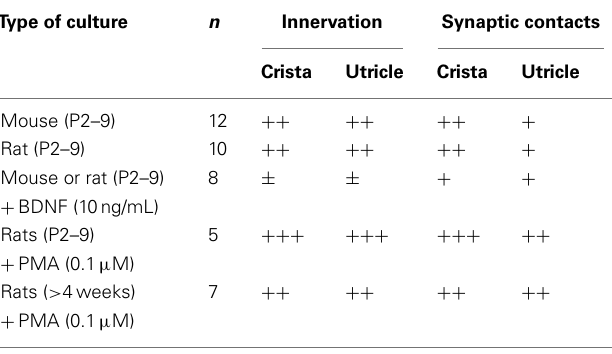
Table 1 | Regeneration of vestibular neurons in different culture conditions. Semi-quantitative comparison of innervation and synaptic contact re-connections evaluated over several experiments (n).